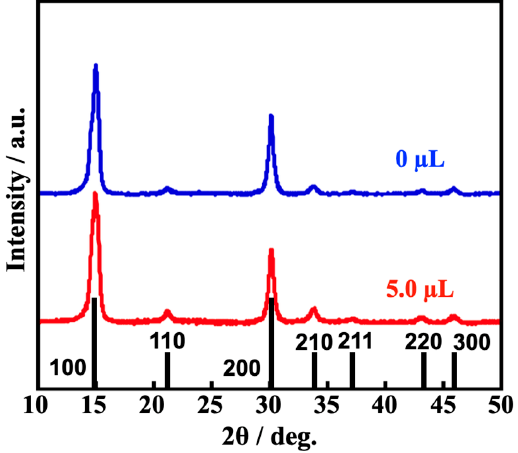
Figure 4. XRD patterns of the MAPbBr 3 PeQDs without water (0 µL) and water-assisted (5 µL). Figure 5a and S4a show the UV-vis absorption spectra of MAPbBr 3 PeQDs without